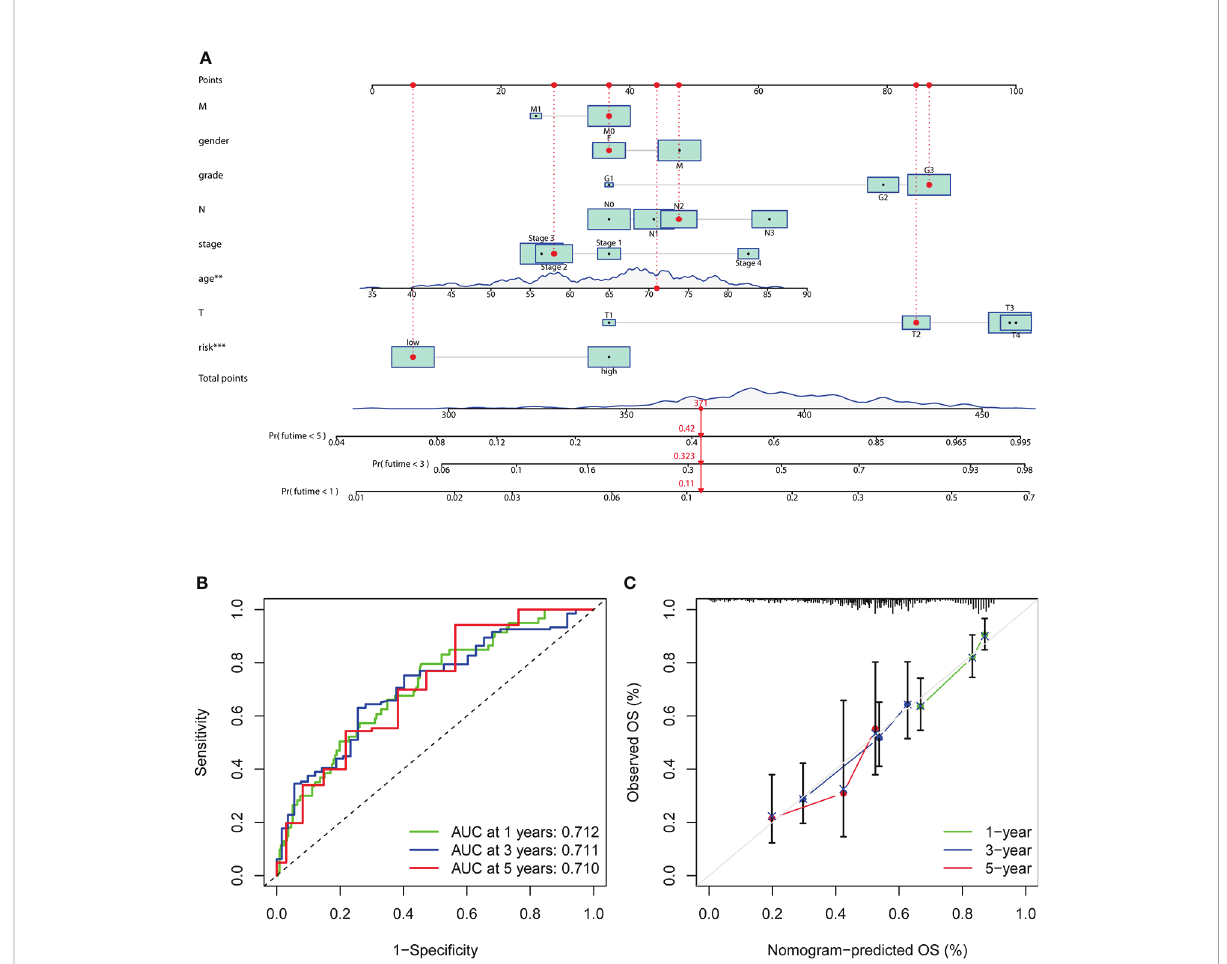
FIGURE 8 Establishment and evaluation of a nomogram. (A) Nomogram based on RS, age at diagnosis, gender, grade, clinical stage, and stage TMN. (B) The ROC analyses of the nomogram in predicting 1-, 3-, and 5-year OS. (C) The calibration curves show the concordance between the actual and nomogram-predicted probability of 1-, 3-, and 5-year